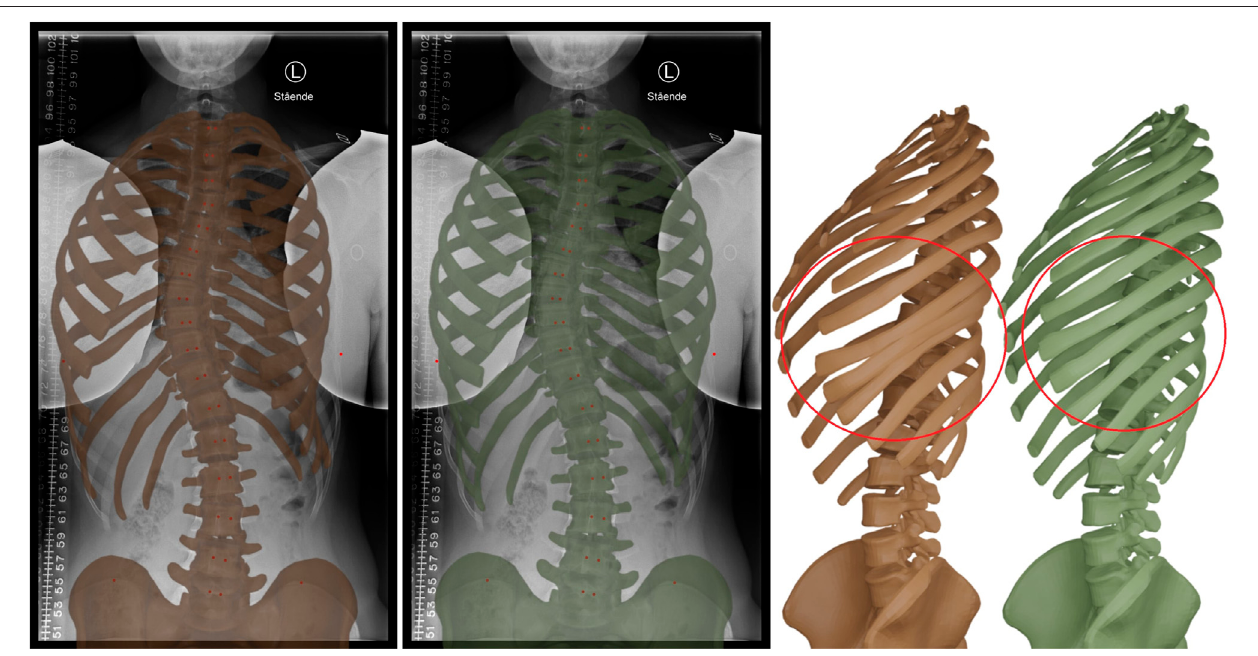
FIGURE 4 | Morphing result without (brown) and with (green) soft tissue in the biomechanical model. The inclusion of the soft tissue provides a stronger regularization effect on the rib cage, and prevents interpenetrations at the ribs, as highlighted on the right.